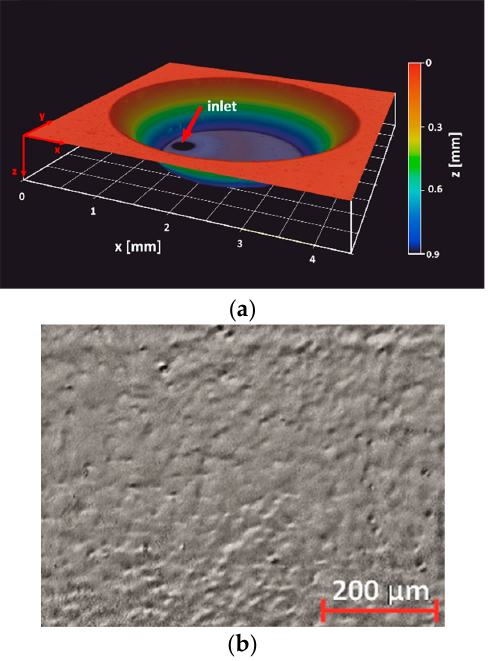
Figure 1. ( a ) 3D topography profile of a finished GB-MBR with microfluidic feed channel inlet (black circular area at the bottom) with entrance diameter of 350 µm, tapered to 150 µm (obtained with laser